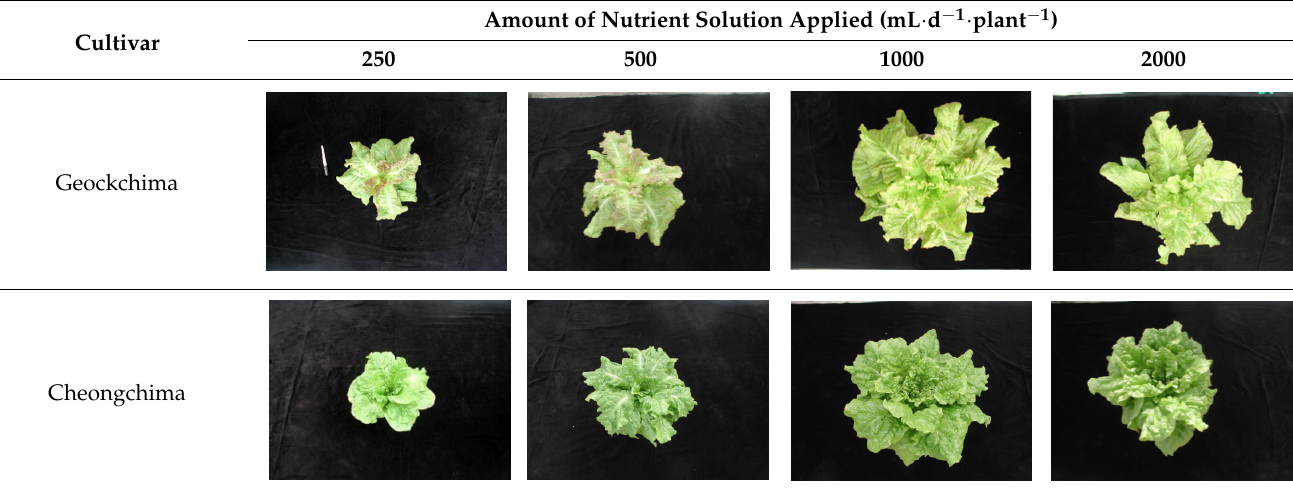
Table 2. Photographs of the crops cultivated in the Geockchima and Cheongchima treatment zones. Cultivar